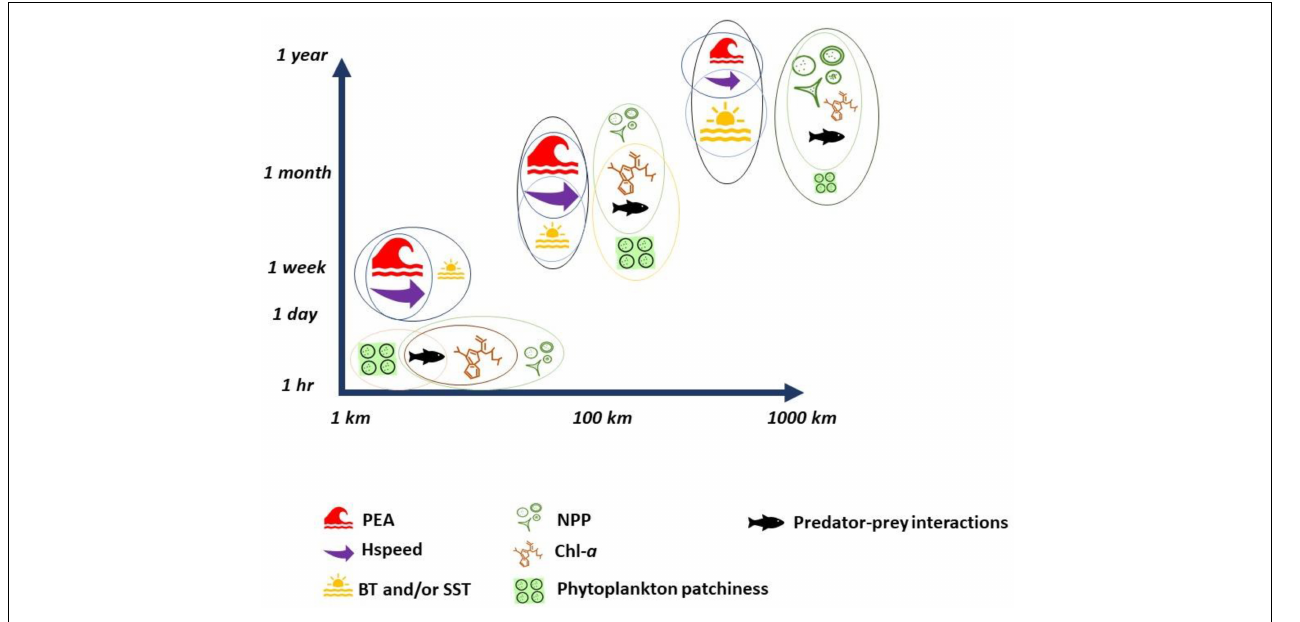
FIGURE 5 | Physical and biological indicators and their overlap (represented by colored circles) across spatial and temporal scales. The size of the symbol represents the relevant “importance” of each indicator at each scale, which was determined, based on all the reviewed literature for this